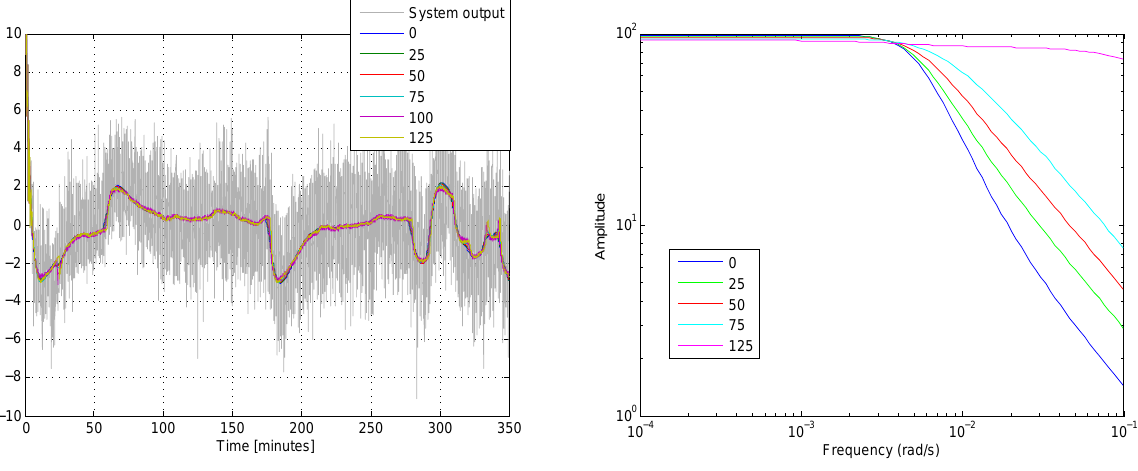
Figure 10: Six polynomial OE models with n b = 1 and n f = 2. The time delay, n d , ranges from 0 to 125 samples in increments of 25 samples.